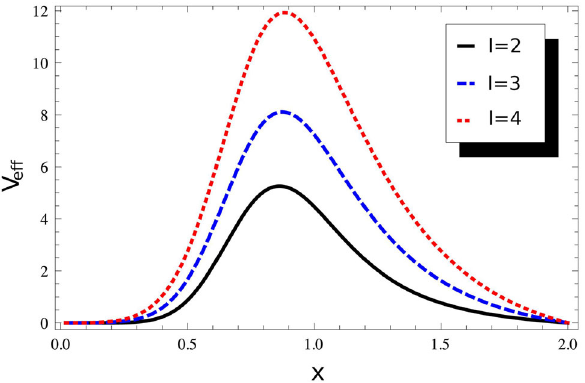
Fig. 3 The effective potential V ef f for l = 2 , 3 , 4 as a function of x